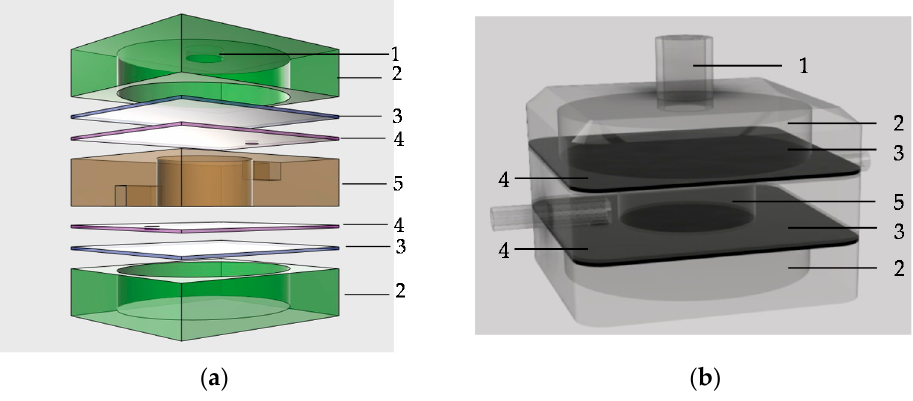
Figure 1. ( a ) Exploded view and ( b ) schematic entity of valveless pump. Table 2. Geometrical specifications of valveless